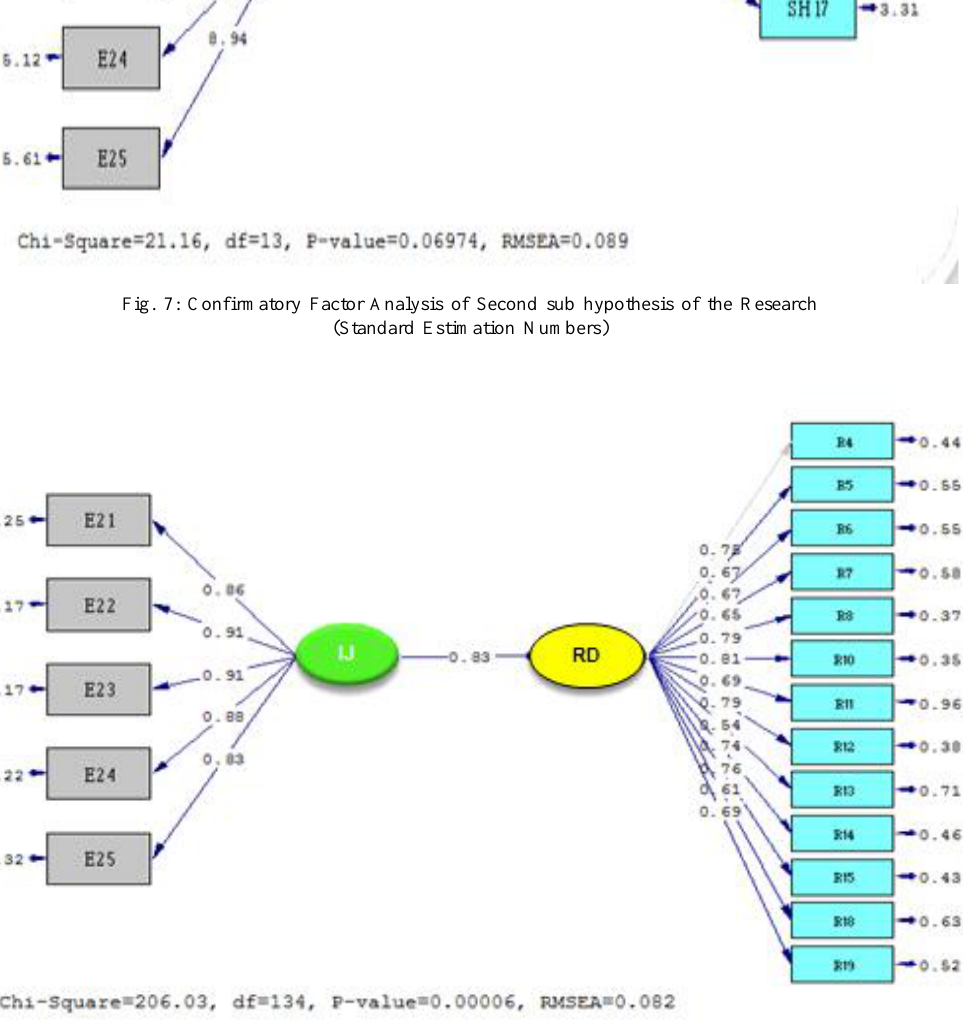
Fig. 8: Confirmatory Factor Analysis of Third sub hypothesis of the Research (Standard Estimation